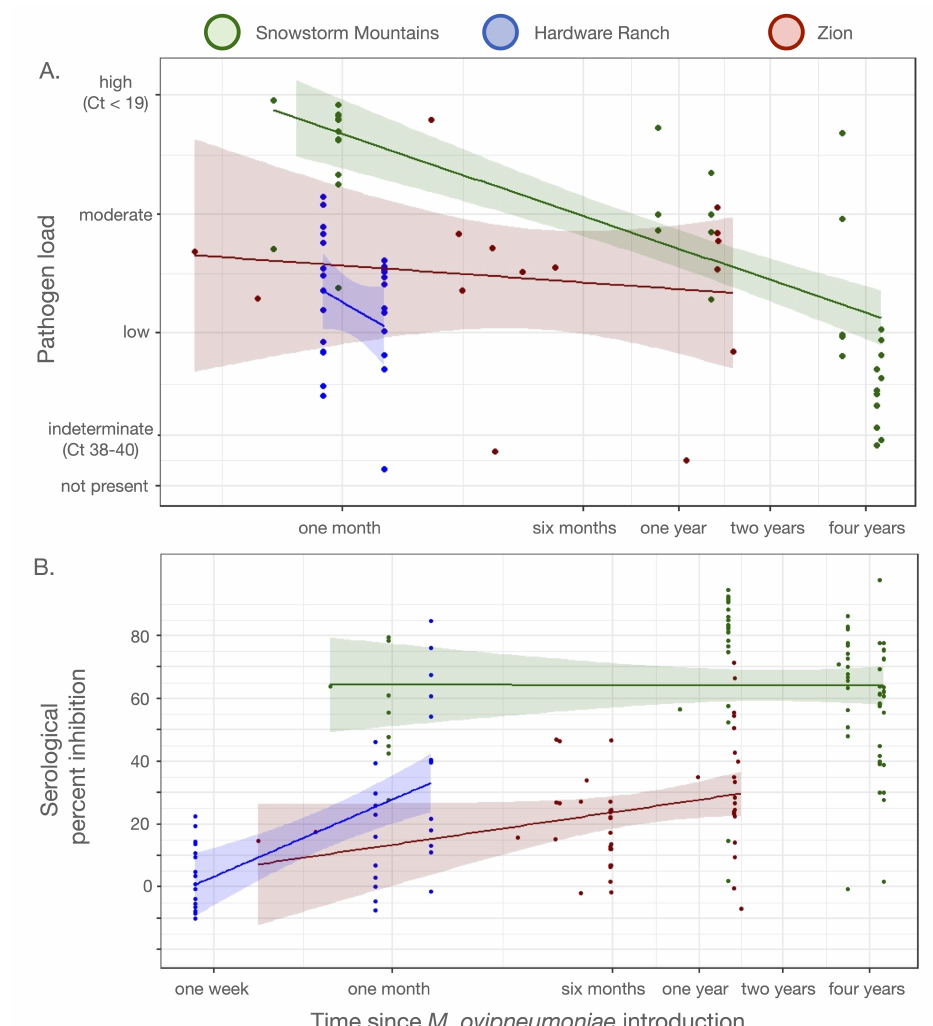
Figure 5. Serological and pathogen load dynamics in the Zion bighorn population (red) in contrast to dynamics from two other example populations: captive Rocky Mountain bighorn sheep at Hardware Ranch in northern Utah (blue); and free-ranging California bighorn sheep from the Snowstorm Mountains in northern Nevada